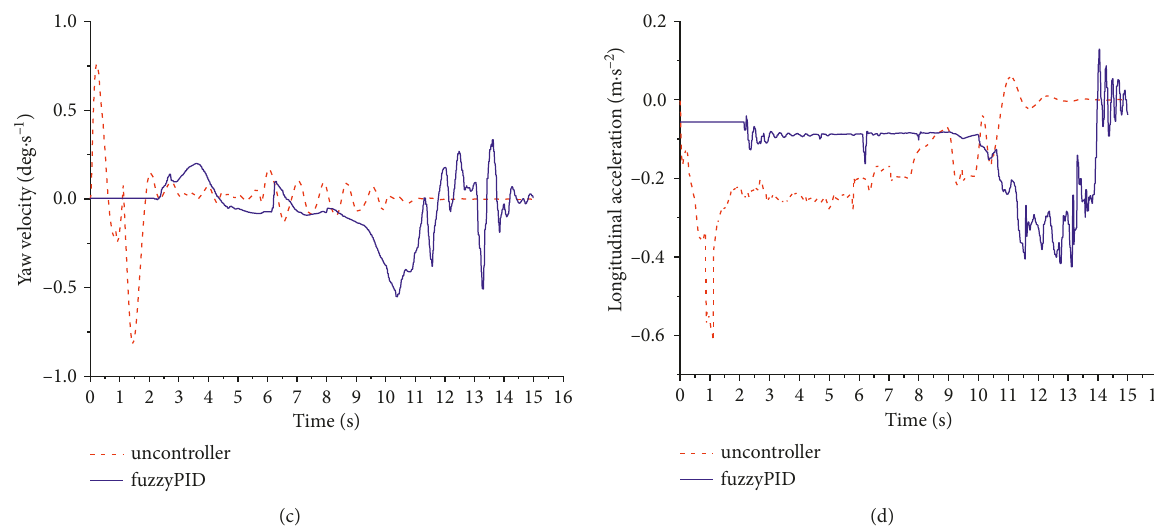
Figure 29: HIL test diagram under long downhill condition when u � 0.5. (a) Braking distance. (b) Lateral acceleration. (c) Yaw velocity. (d) Longitudinal acceleration.